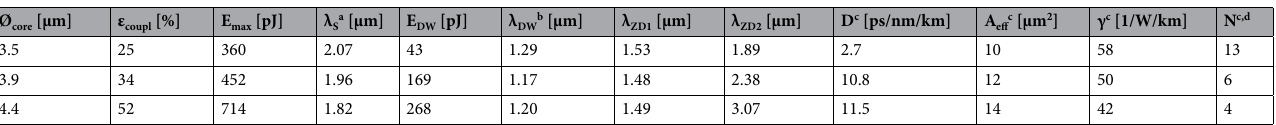
Table 2. Measured key quantities, calculated dispersion, and nonlinear parameters of the investigated fibers, determined at a max. in-fiber energy E max , b at onset energy of the respective DW E DW , c at λ P , and d at 350 pJ.